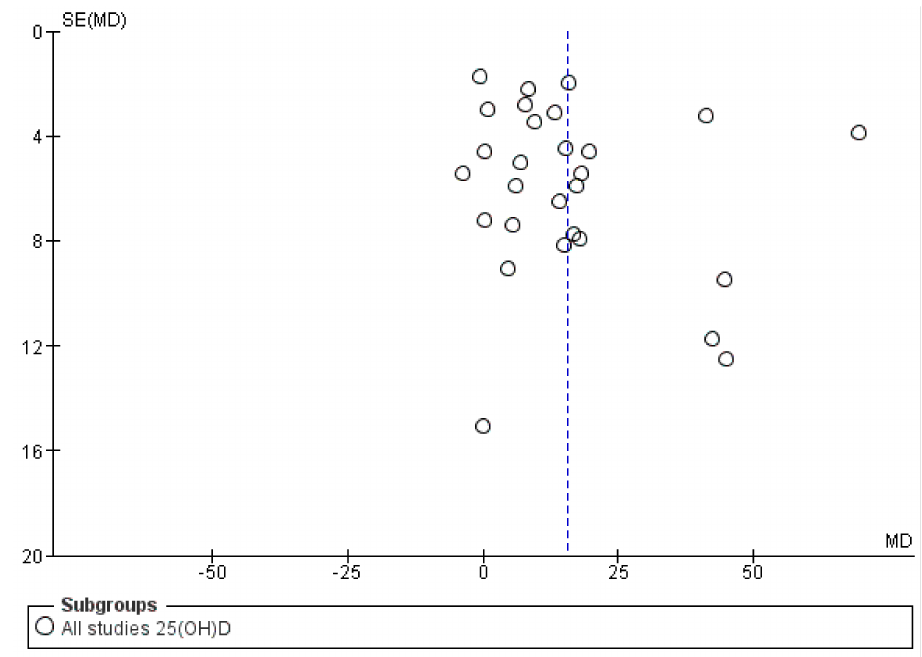
Figure 3. Forrest plot analysis of serum total 25(OH)D: sub-group analysis based on daily dosage. Legend: Forrest plot of random effect meta-analysis comparing the effects of cholecalciferol vs. ergo- calciferol supplementation on net changes in 25(OH)D concentrations favored cholecalciferol. Sub- group analyses in studies with daily dosage ≤ 1000 nmol/L, 1000–4000 nmol/L and ≥ 4000 nmol/L of the respective vitamin D forms showed higher serum 25(OH)D levels among the cholecalciferol group as compared to ergocalciferol group in all groups. The heterogeneity of the subgroup analysis was high ( I 2 > 65%). The test of subgroup difference was statistically significant ( p = 0.03).